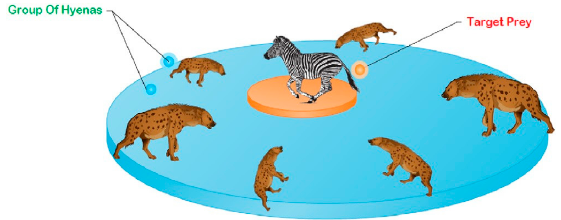
Figure 7. Figure 4. Two dimensional position of spotted hyena. Figure 4. Two dimensional position of spotted hyena.